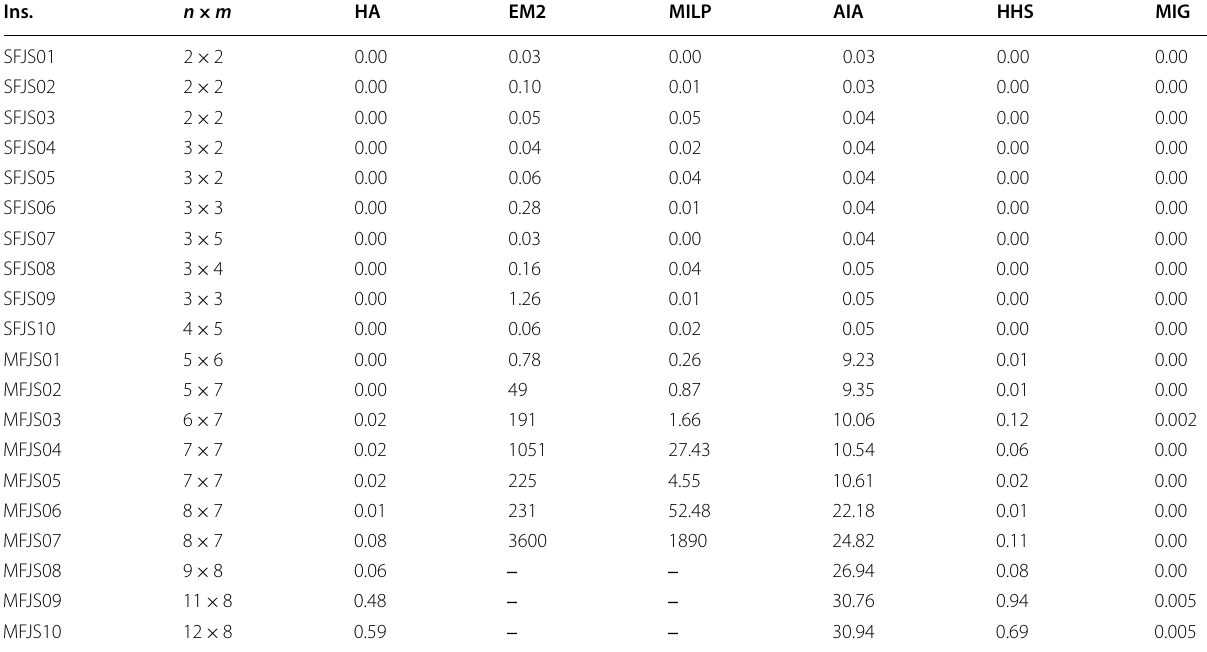
Table 4 CPU time comparison for instances in experiment 2 Ins.